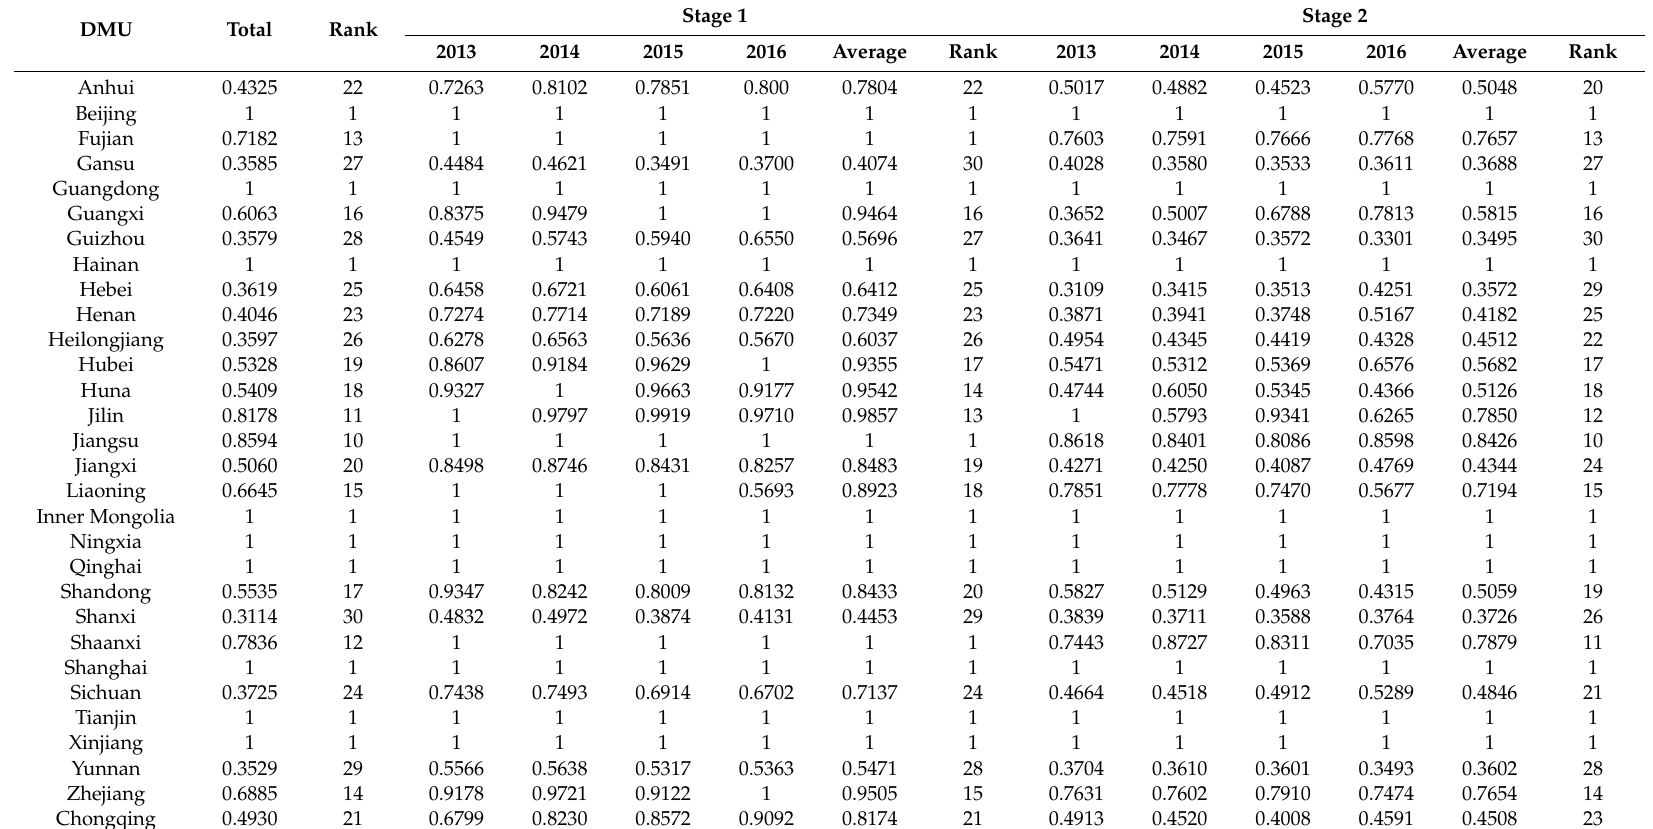
Table A1. Two stage e ffi ciencies by provinces from 2013 to